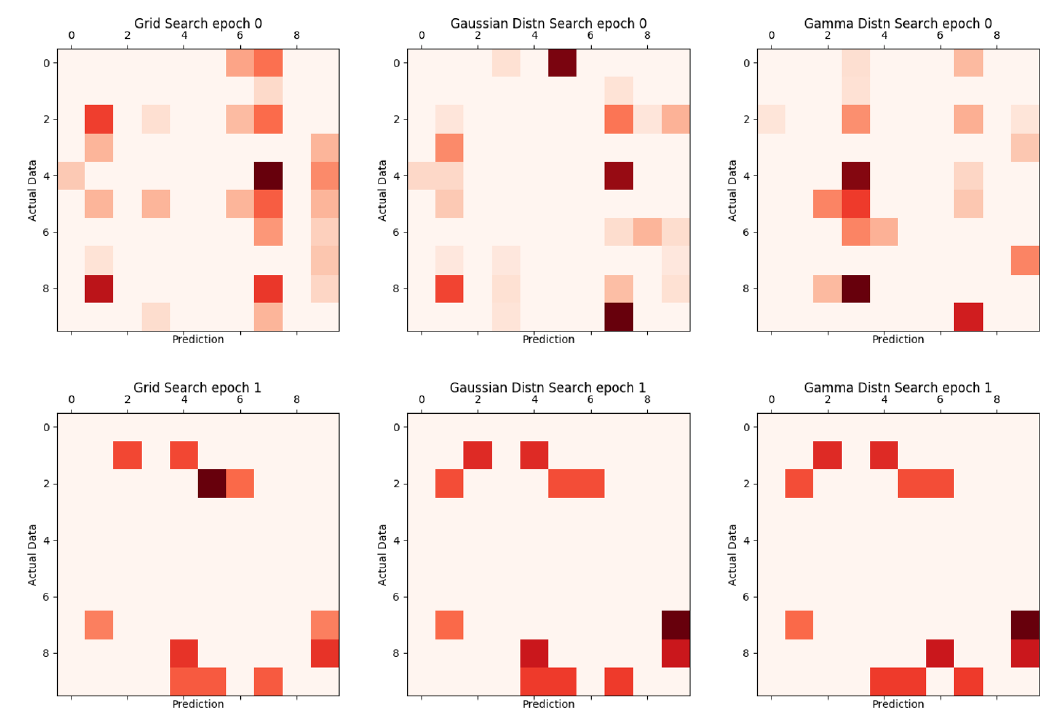
Figure 12. Existing comparison of grid search, Gaussian distribution search, and Gamma distribution search.